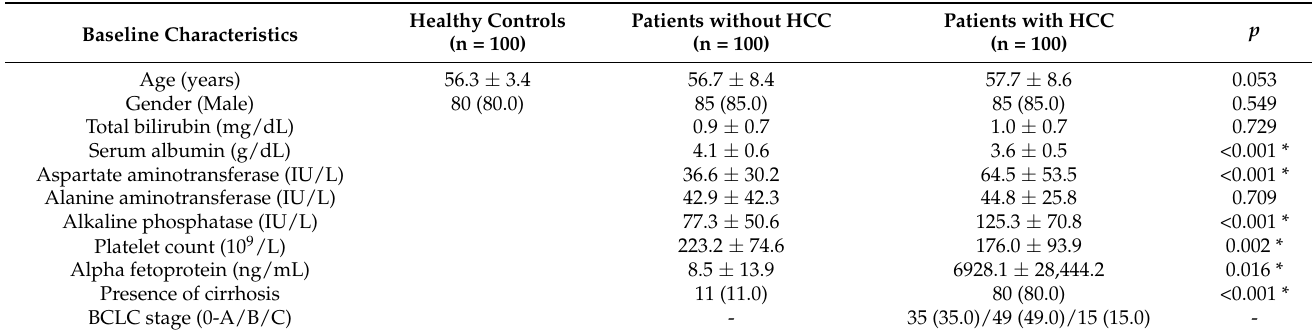
Table 1. Baseline characteristic of patients in the validated